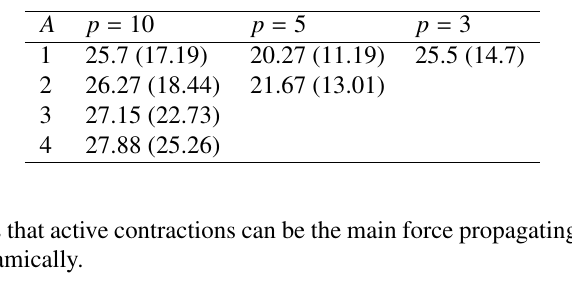
Table 4. Pressure appearing as a result of calculations in the LS graph with natural gravity force influence. A (mm Hg) — amplitude of contractions, p (mm Hg) — characteristic pressure in the calculation (initial pressure gradient is zero). There is resultant maximum pressure gradient (mm Hg) in the cells and values of maximum pressure (mm Hg) in the parentheses